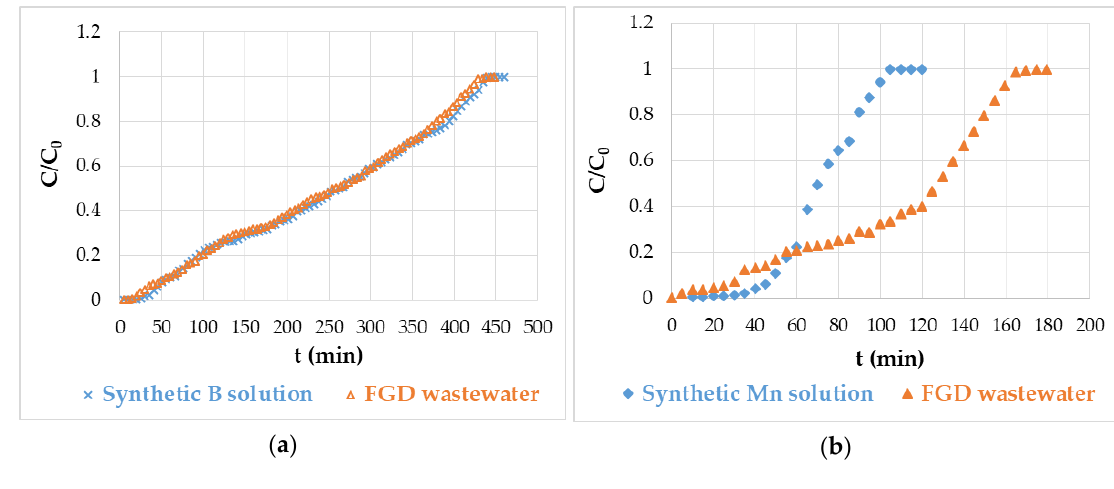
Figure 2. Boron ( a ) and manganese ( b ) breakthrough curves on hybrid chitosan-zirconium hydrogel beads. Table 3. Evaluation of the column mode performance of the hybrid chitosan-zirconium hydrogel beads for boron and manganese ions’ removal.